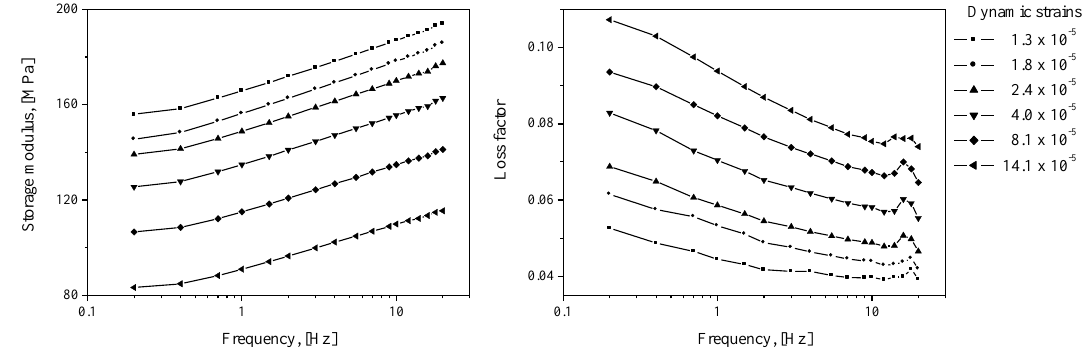
ε = 11%; storage modulus: Re[ E* ], loss factor: Im[ E* ] / Re[ E* 0